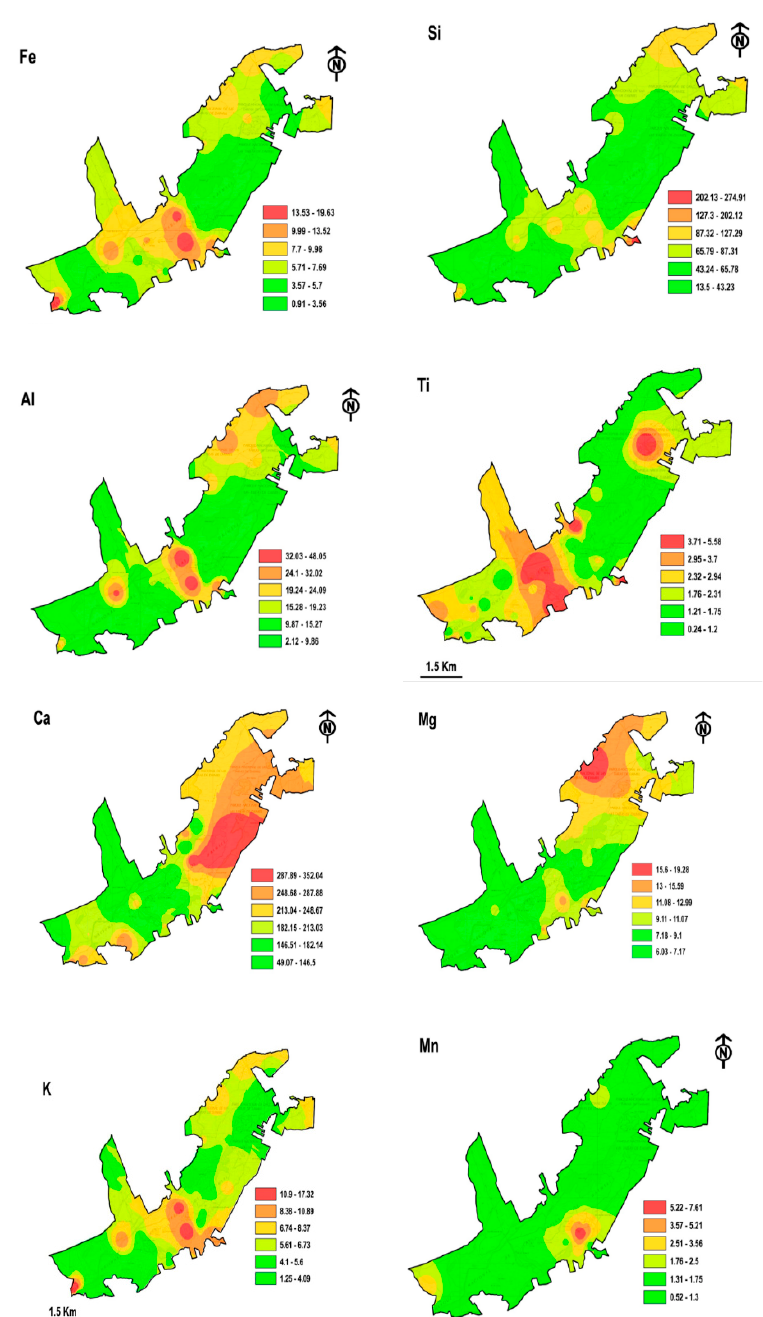
Figure 5. Spatial variability of Fe, Si, Al, Ti, Ca, Mg, K, and Mn (g · kg − 1 ) in the soils of the flood zone of the TDNP.